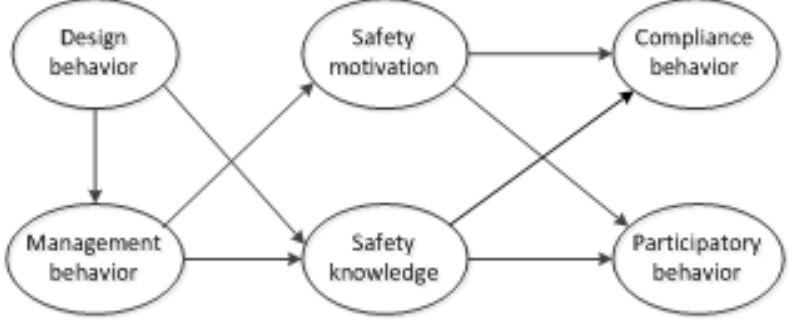
Figure 1. Path Diagram of the Theoretical